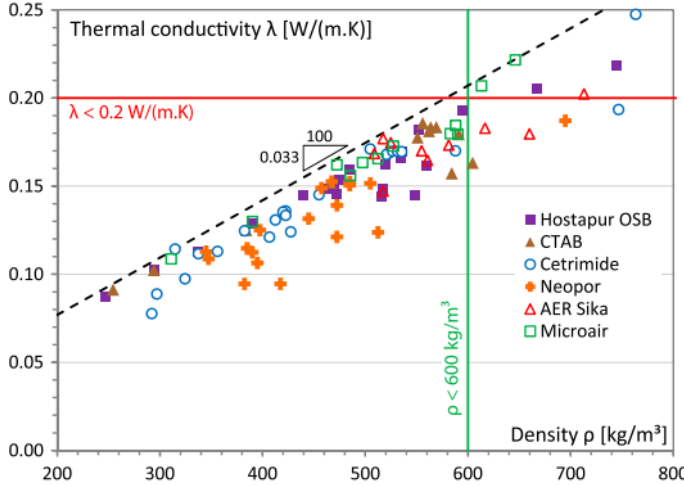
Figure 7. FC thermal conductivity versus its foam density [206]. Reprinted with permission from Samson el al. (2017) Samson el al. (2017) [206].